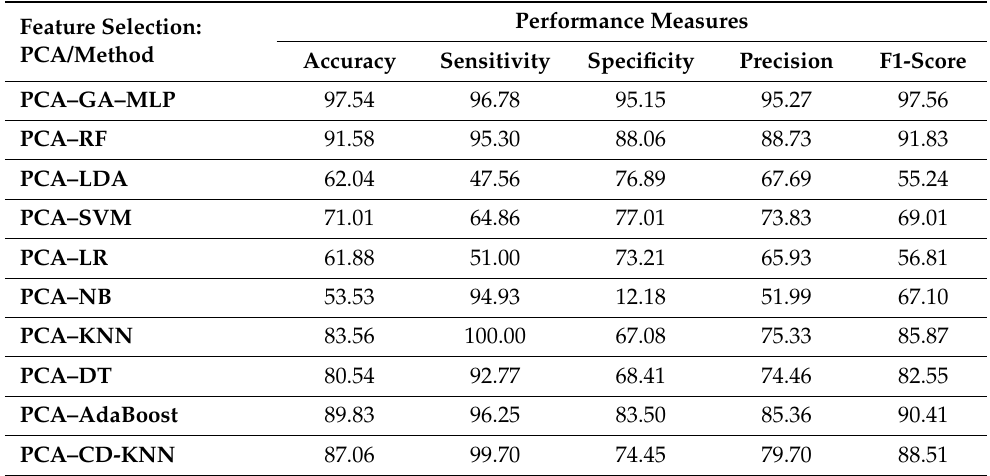
Table 9. Comparison of the proposed method using four feature selection methods with nine other classification algorithms in diagnosing